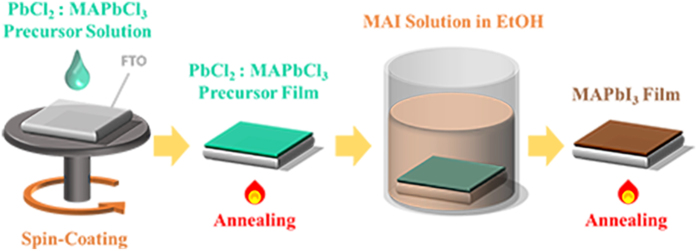
Schematic illustration of the experimental procedure.Various ratios of PbCl2: MAPbCl3 were initially deposited on the substrate, and then the MAI-dissolved ethanol solution was utilized to synthesize MAPbI3.